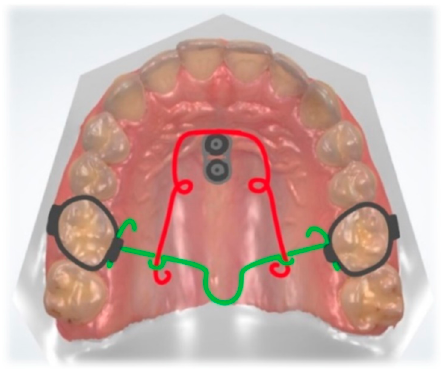
Figure 9. Mouse trap appliance. Lever arms connected to TADs, activated for molar intrusion (red). Transpalatal arch (green).